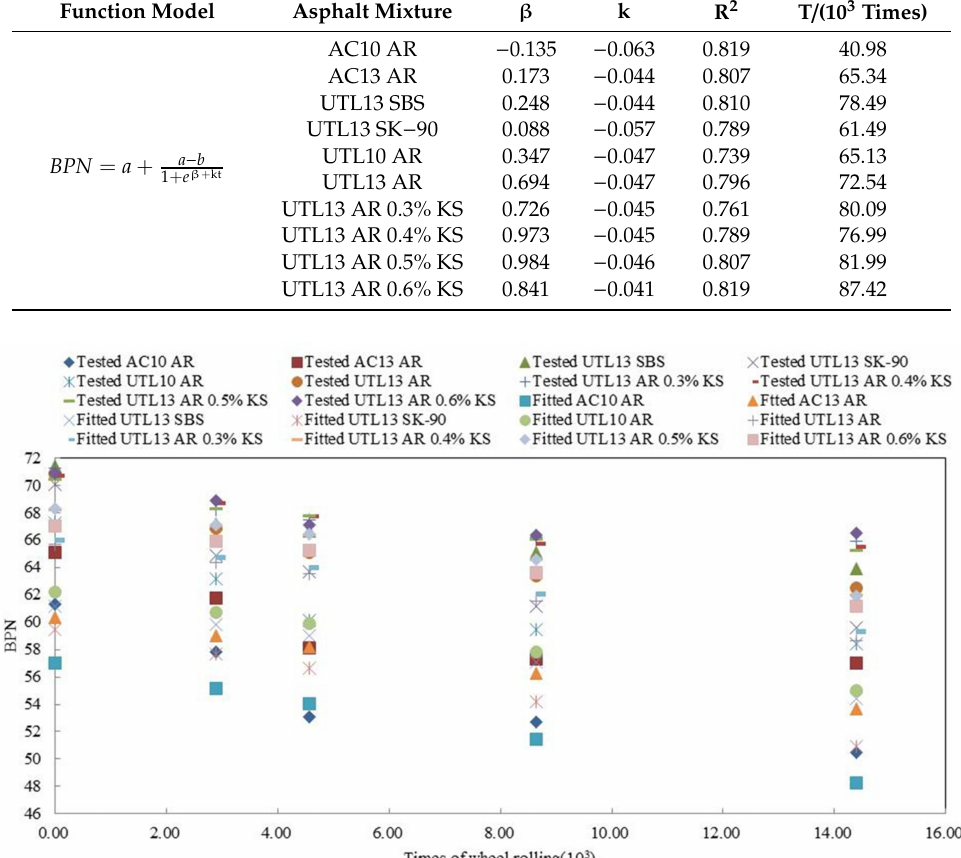
Figure 15. Comparison between the model calculation values and the tested values of di ff erent asphalt mixture.